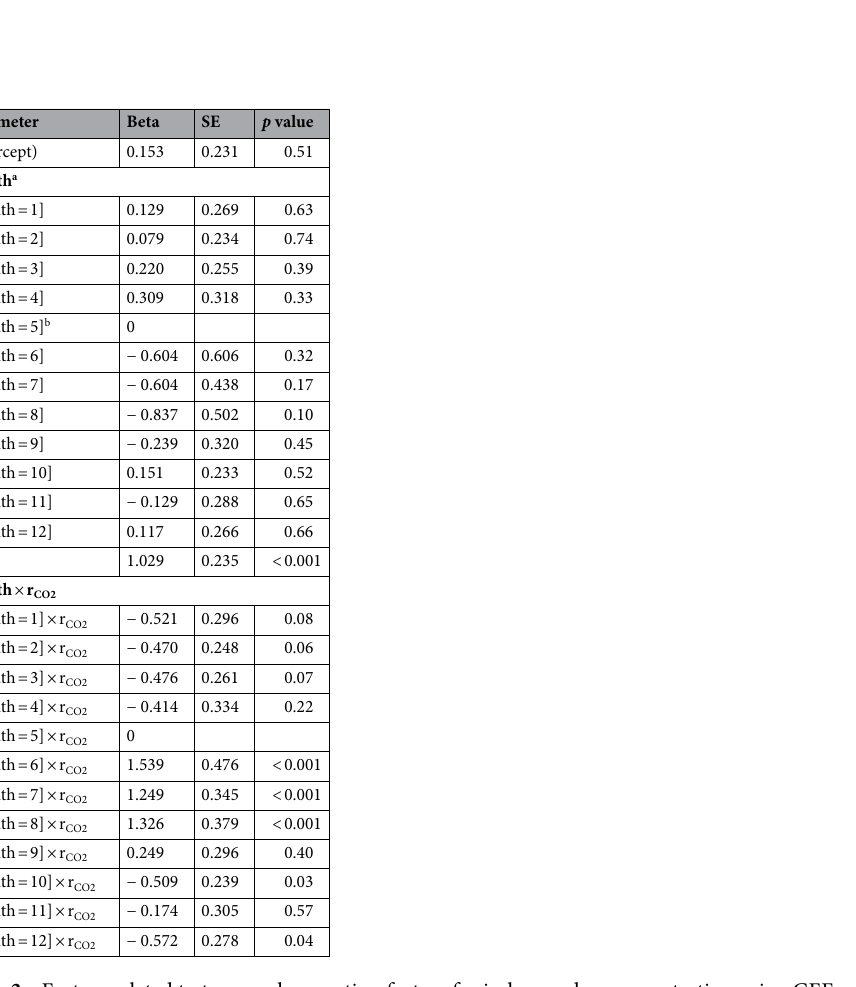
Table 3. Factors related to temporal correction factors for indoor radon concentration using GEE method. Dependent variable: Radon temporal correction factors. a The reference category was month = 5. b This parameter is set to zero because it is